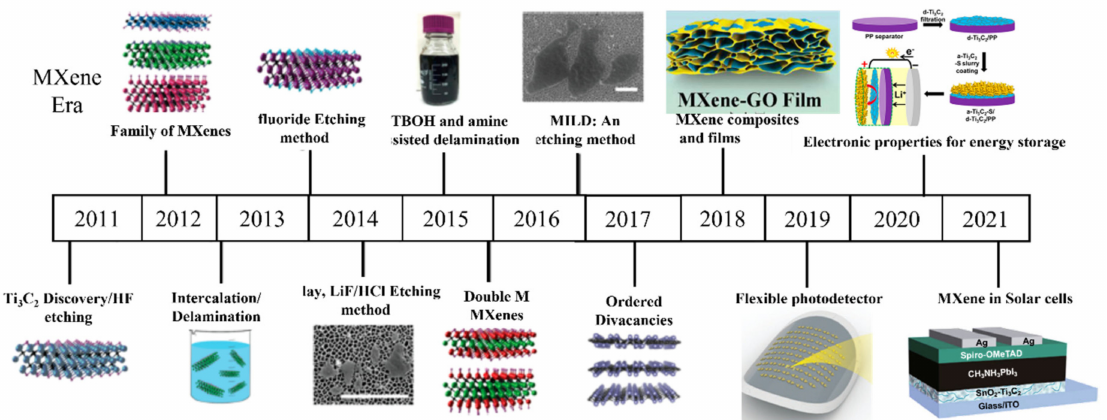
Figure 2. Development in the synthesis of MXenes (reproduced with permission [50].